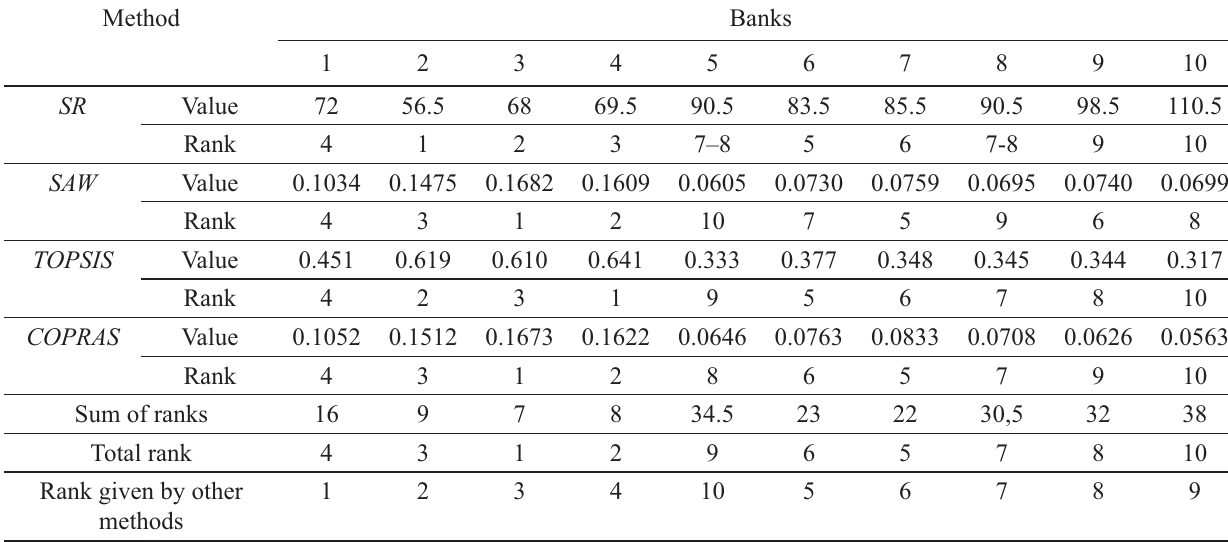
Table 9. The results obtained in comparing the reliability of Lithuanian commercial banks by multicriteria methods